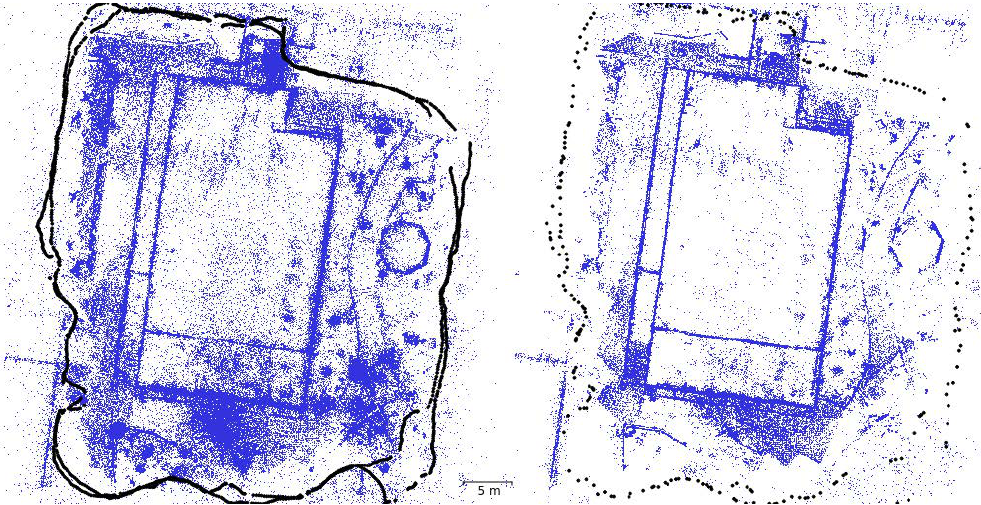
Figure 19. The outputs of running the SfM procedure on the images of continuous image capturing ( left ) and continuous image capturing & clustering and selection ( right ) modes. The black dots in the figures show the position of the camera, and the blue dots represent the sparse point cloud of the building and its